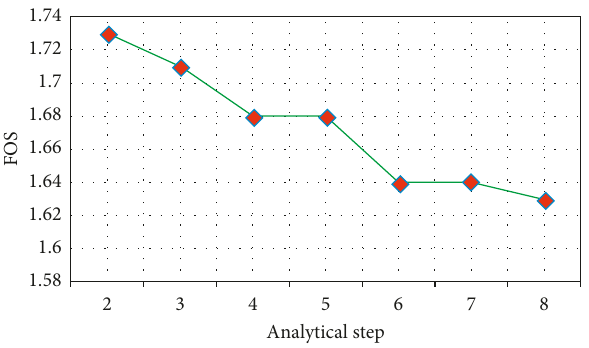
Figure 12: FOS of each analysis step.